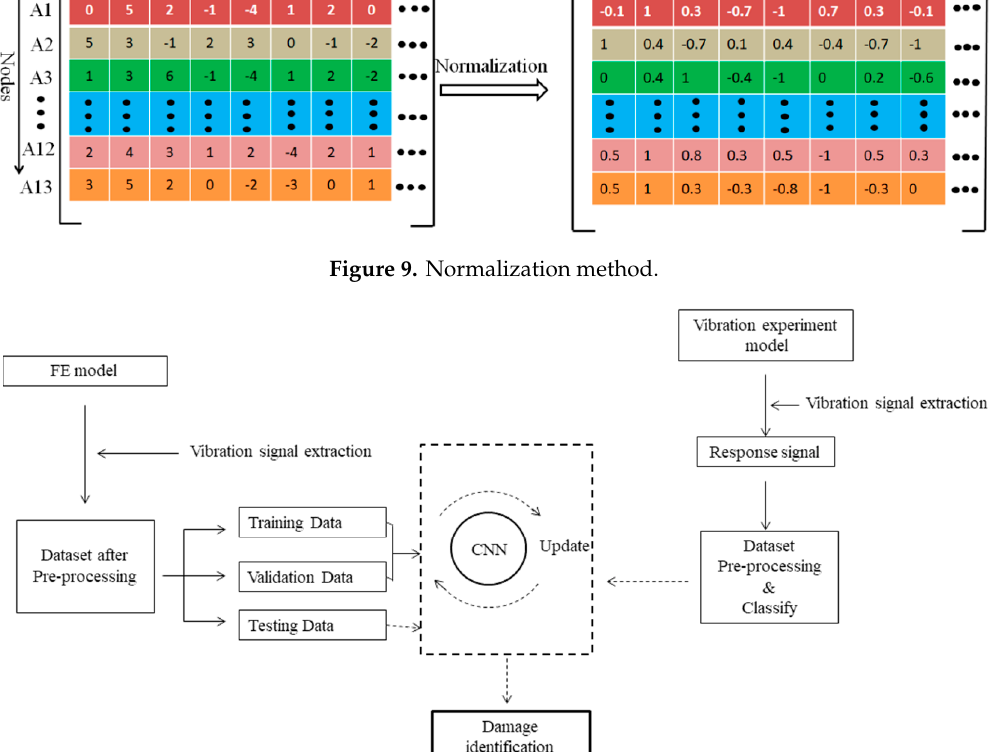
Figure 10. Overview of damage detection process.